Question: Summarize what this figure shows in one sentence.
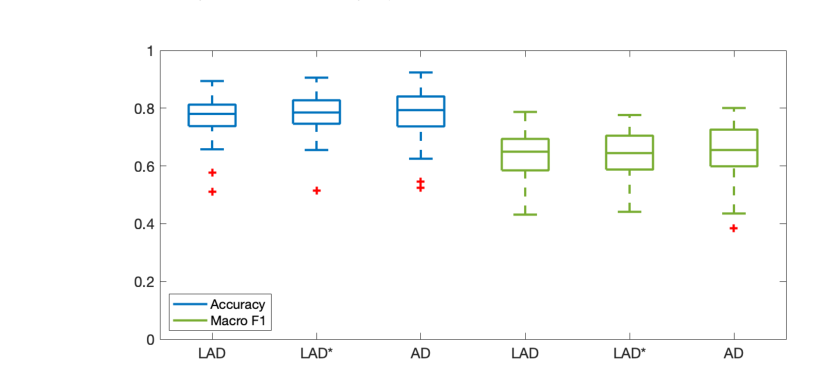
Answer: The box plot of 40-fold validation accuracies by dif- ferent methods. LAD stands for Landmark AD without class- balanced landmark set fusion 2 channels; LAD* stands for Land- mark AD with class-balanced landmark set fusion 2 channels AD stands for AD fusion 2 channels and O1A2, O2A1 stands for dif- fusion map on single channels.